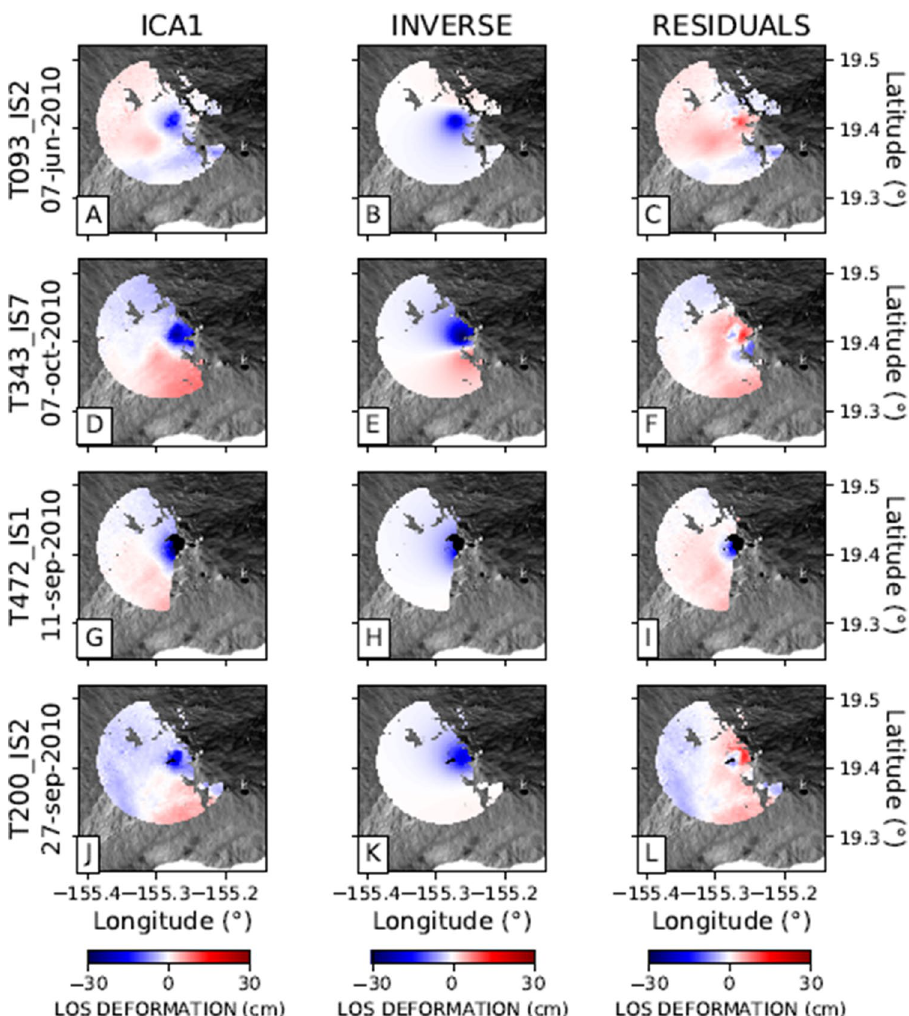
Figure 5. Inverse modelling of the Kīlauea ground deformation source for four selected tracks: ( A ), ( B ), ( C ): ENVISAT 093 orbit; D, E, F: ENVISAT 343 orbit; G, H, I: ENVISAT 472 orbit; J, K, L: ENVISAT 200 orbit, respectively. Column 1 represents the first component (ICA1) encompassing a radius of 11 km from Halema’uma’u Crater. Column 2 represents the Mogi analytical model as a result of the inverse modelling. Column 3 shows the residuals of the inverse modelling and the observed